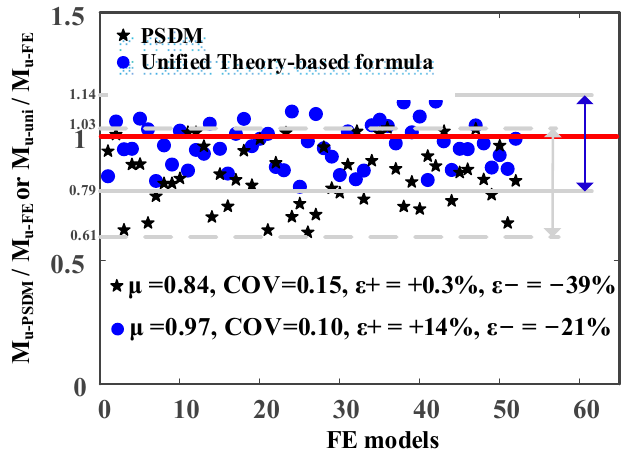
Figure 14. Comparison of predicted results (from PSDM and Unified Theory) against numerical results.